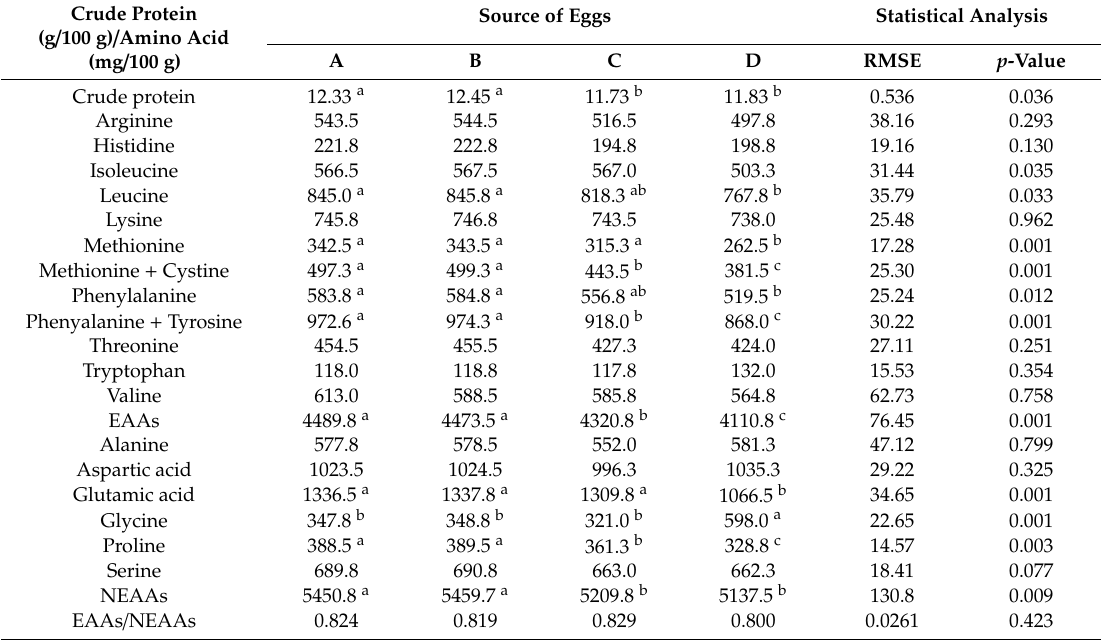
Table 2. Crude protein and amino acid patterns of albumen of eggs of di ff erent sources in the retail